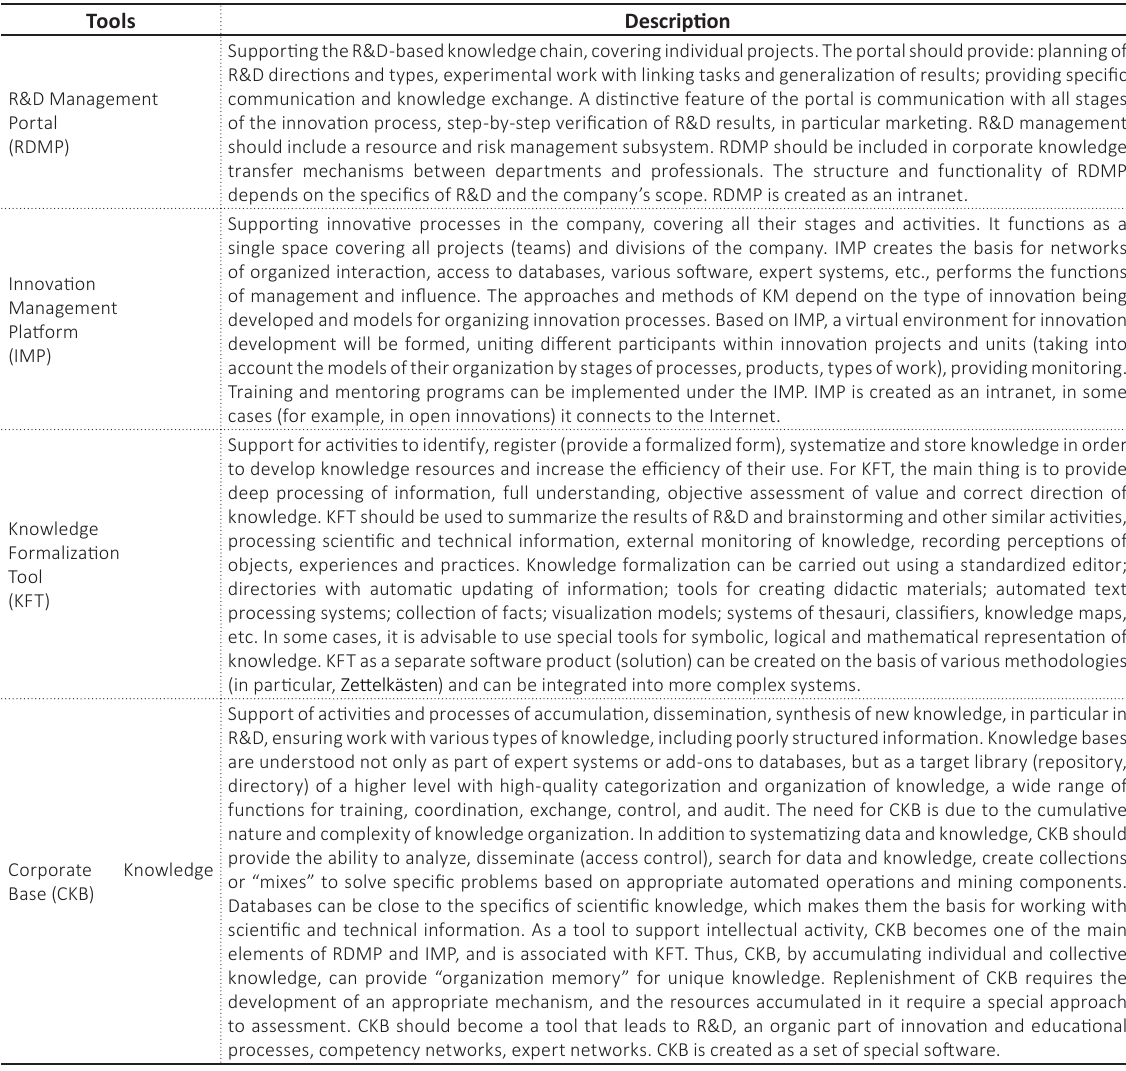
Table 1. Information portals and tools in the company’s KMS